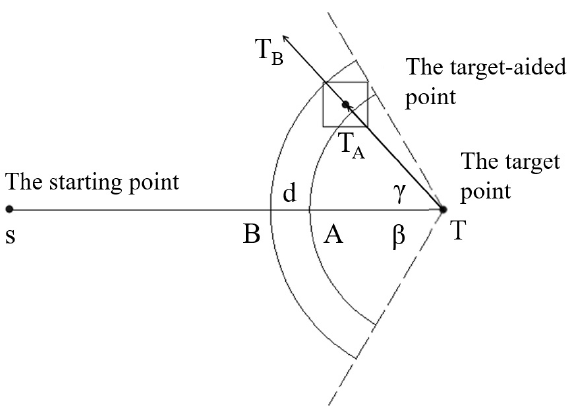
Figure 12. The setting of target aided point